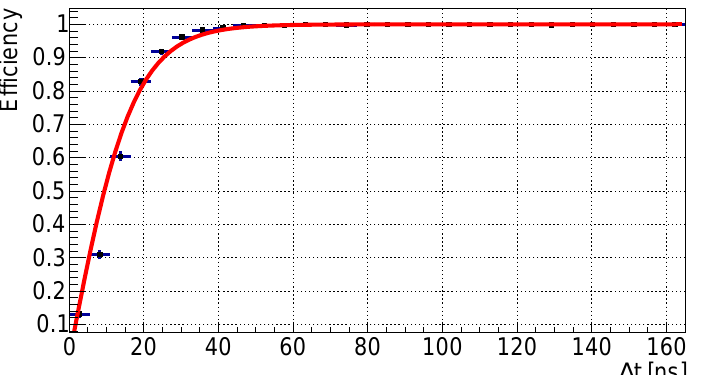
Figure 3. Efficiency of a signal-counting CNN as a function of the time difference between two − 0.5 ) is fitted (red). For signals signals. A sigmoid curve for the efficiency Eff = 2 · ( 1 ( 1 + exp ( − ∆ t /70 ) with ∆ t = 10 ns, the efficiency is 50%. The efficiency reaches 100% for ∆ t > 50